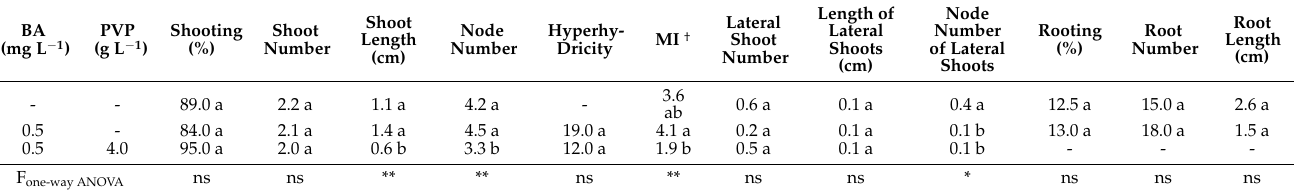
Table 2. Establishment stage: initial cultures of node explants excised from in vitro-grown, young seedlings of Sideritis raeseri subsp . attica on MS media without hormones (Hf) or supplemented with